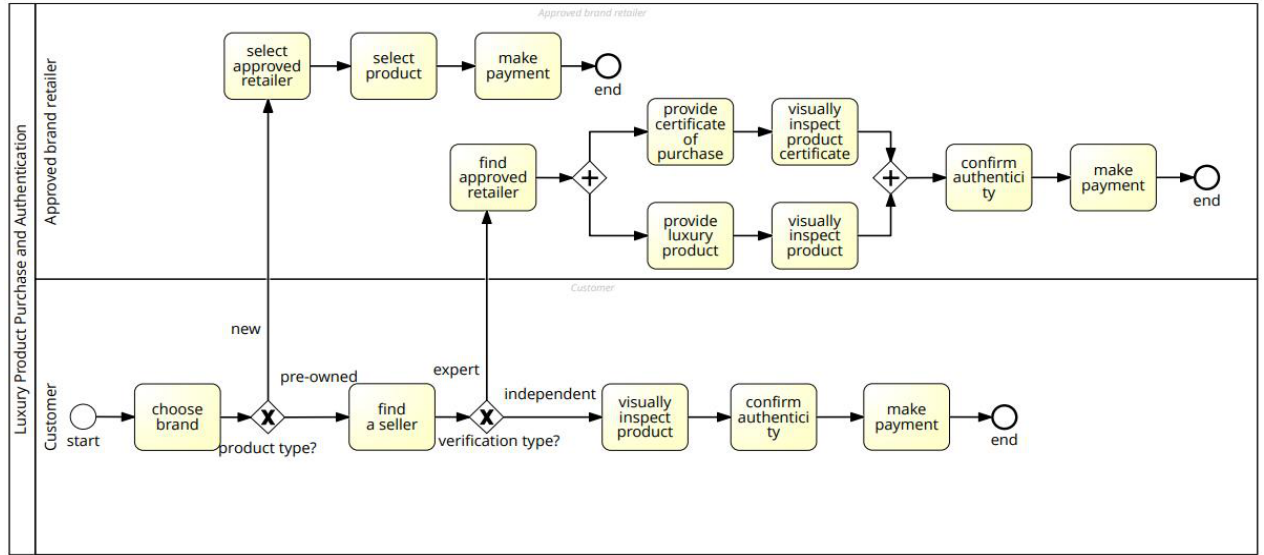
Figure 2. The current process of luxury product